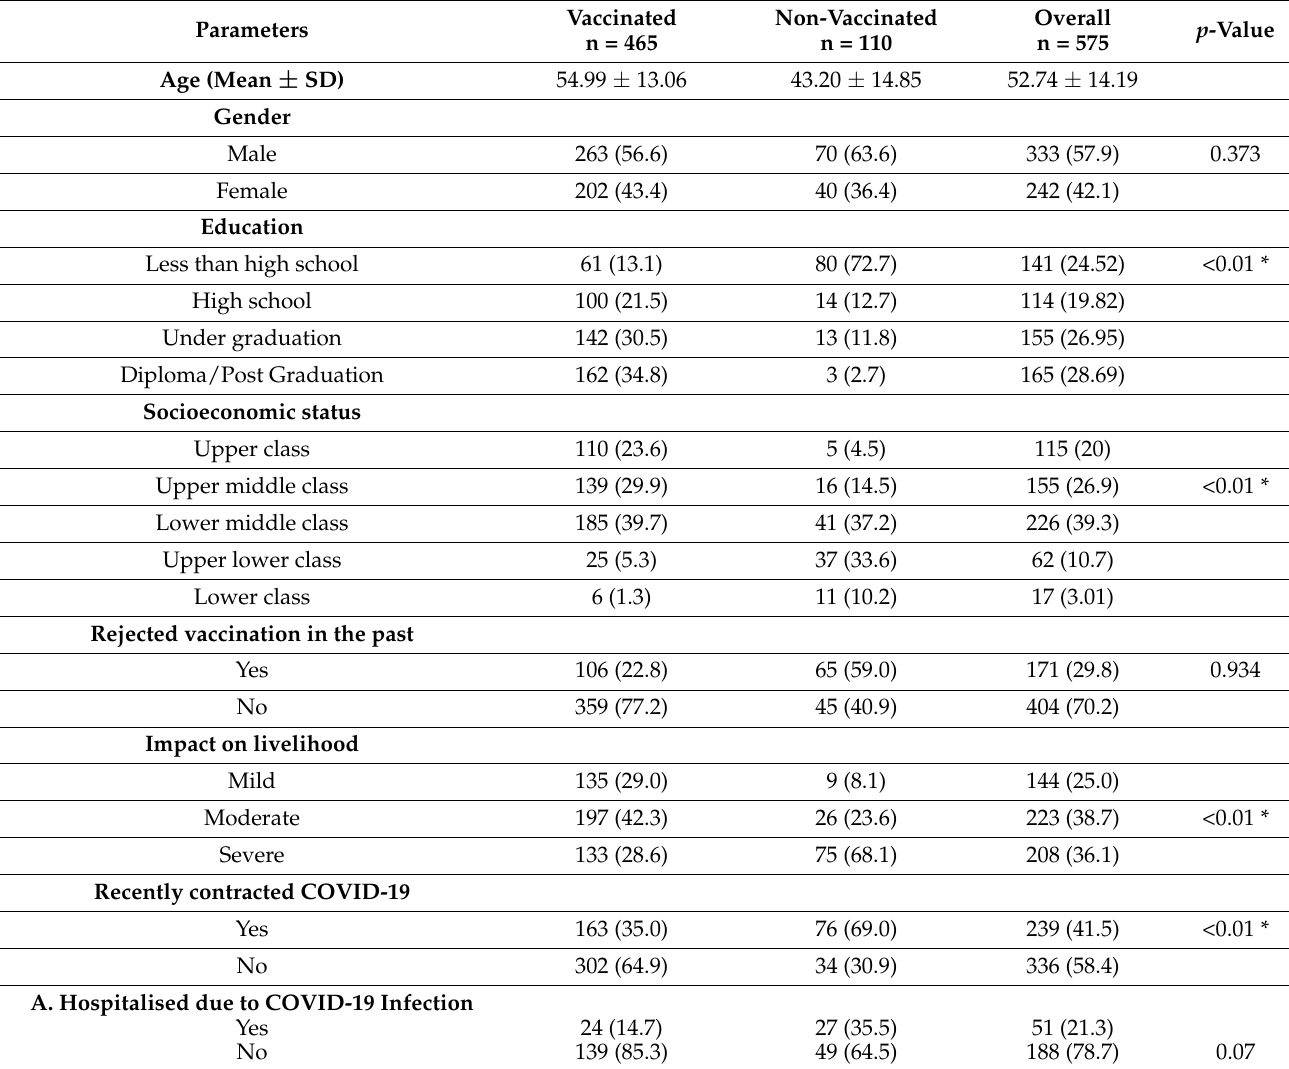
Table 1. General Characteristics of Participants in the